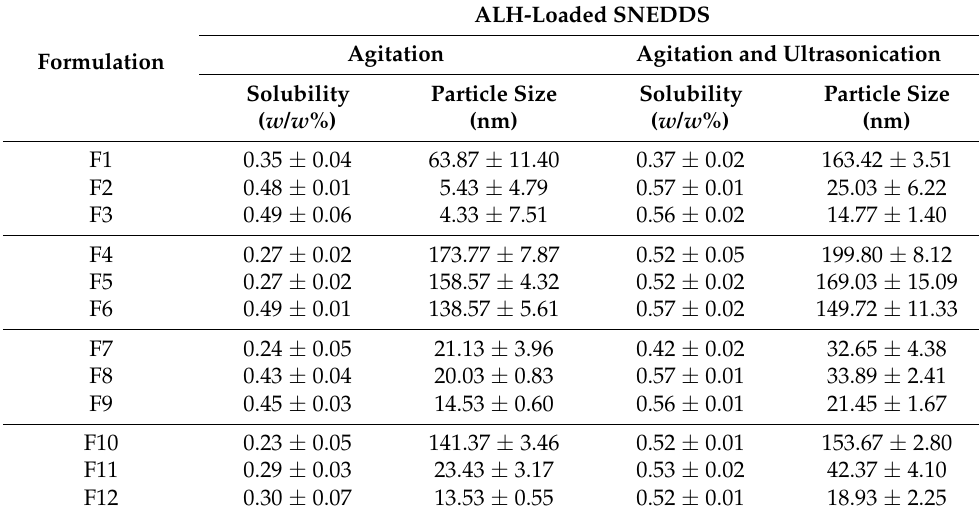
Table 3. Solubility and particle size for the ALH-loaded SNEDDS prepared from agitation and ultrasonication. All data are expressed as the mean ± SD ( n =